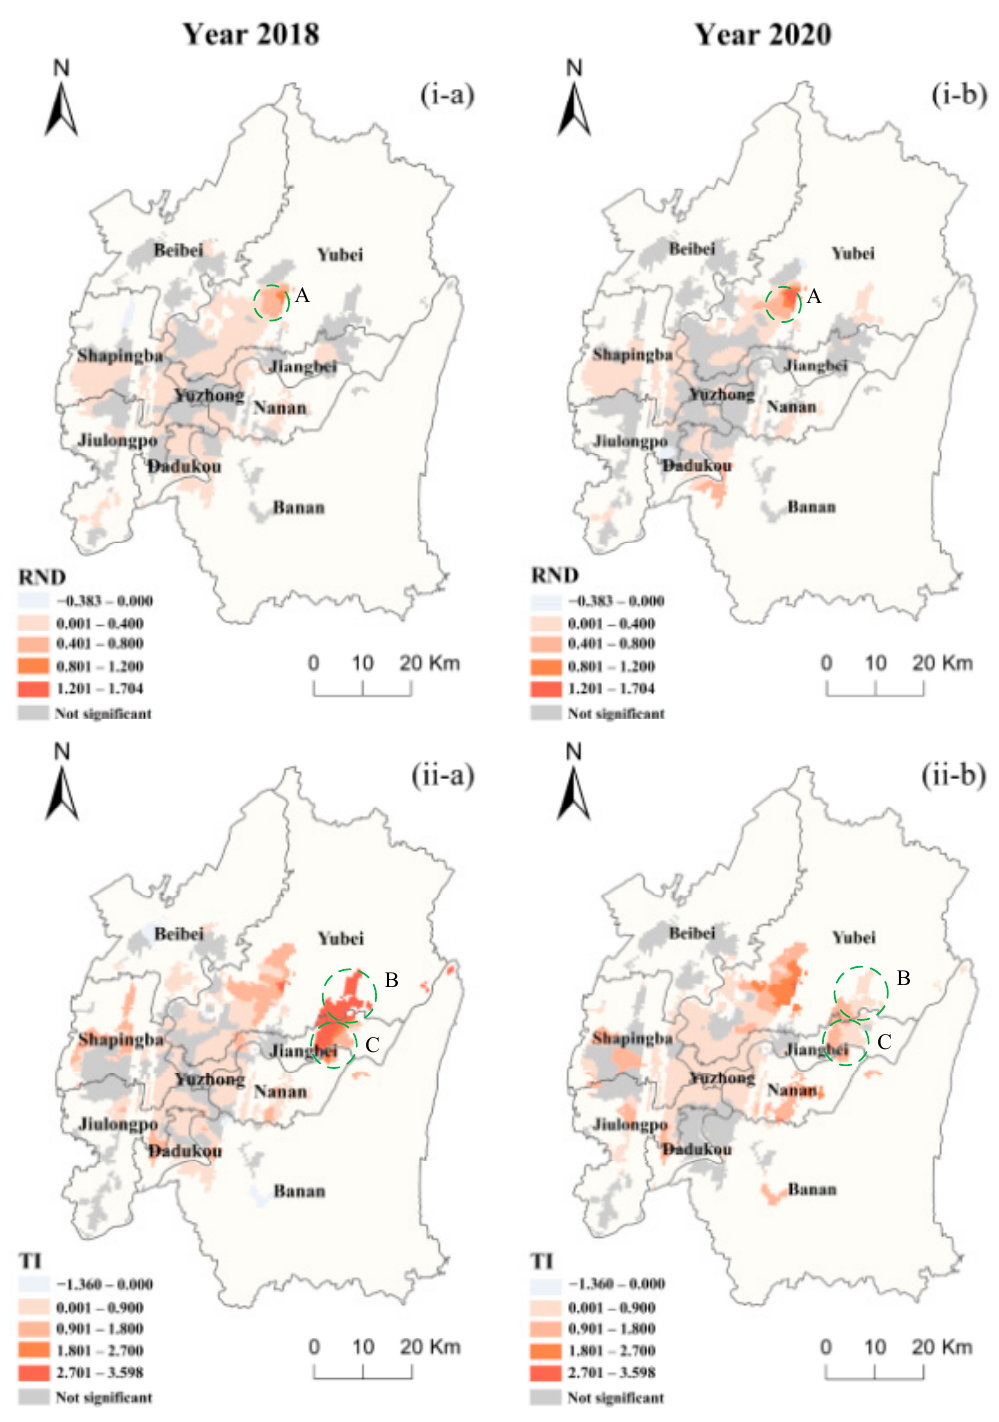
Figure 4. Spatial distributions of the coefficients of ( i ) road network density and ( ii ) transportation index in ( a ) 2018 and ( b ) 2020 (RND: road network density; TI: transportation index; Region A is the Airport; Region B is the Longxing town; Region C is the Yufu town).